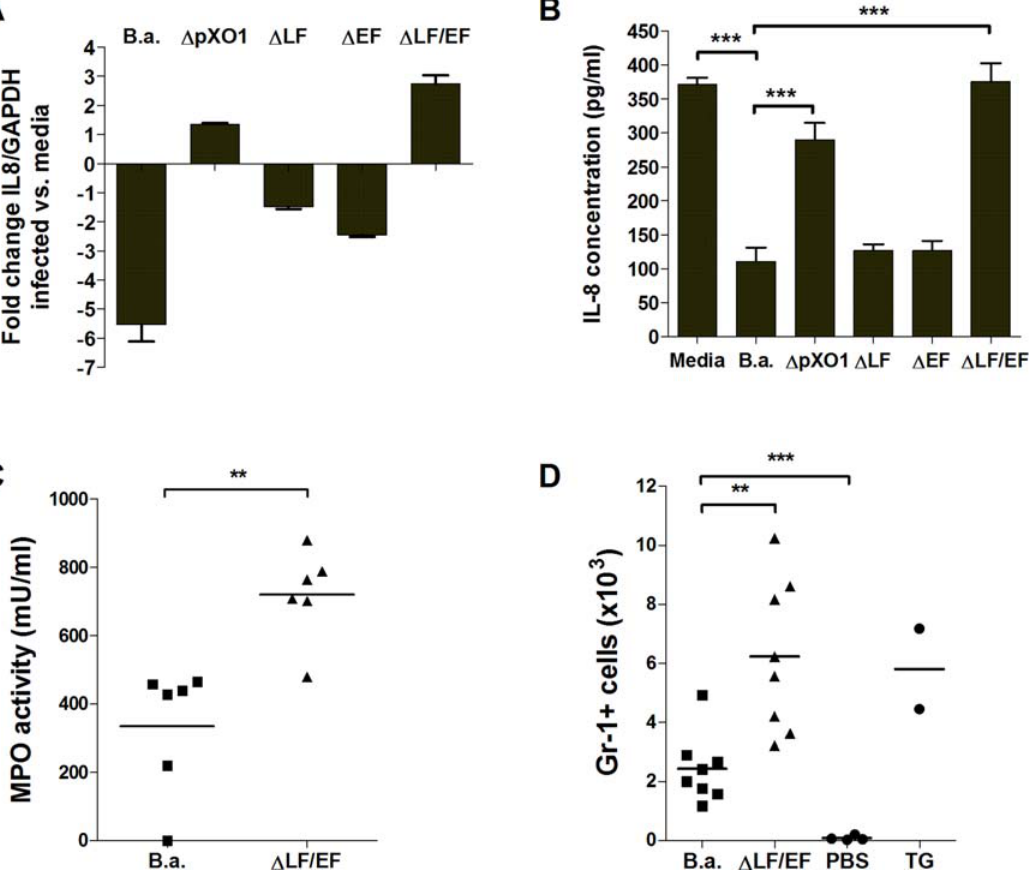
Figure 6. Anthrax toxins impair IL8 expression and neutrophil chemotaxis (A) IL-8 mRNA expression levels upon infection with B. anthracis Sterne (B.a.), D pXO1, D LF, D EF or D LF/EF mutant bacteria using quantitative RT-PCR. Data represent mean and standard deviation of three independent experiments performed in triplicate. (B) Protein expression of IL-8 in hBMEC supernatants 6 h post infection with B. anthracis Sterne, D pXO1, D LF, D EF or D LF/EF mutant bacteria using ELISA. Experiments were performed three times in triplicate. Bars represent mean and standard deviation of one representative experiment. Neutrophil recruitment in vivo was assessed by measuring (C) myeloperoxidase (MPO) activity in skin homogenates 4 h post infection or by (D) quantification of Gr-1 + cells upon peritoneal injection with B. anthracis Sterne (B.a.), toxin- deficient bacteria ( D LF/EF), PBS or thioglycolate positive control (TG). Bars indicate mean levels of neutrophil recruitment. ** p , 0.005; *** p , 0.001.